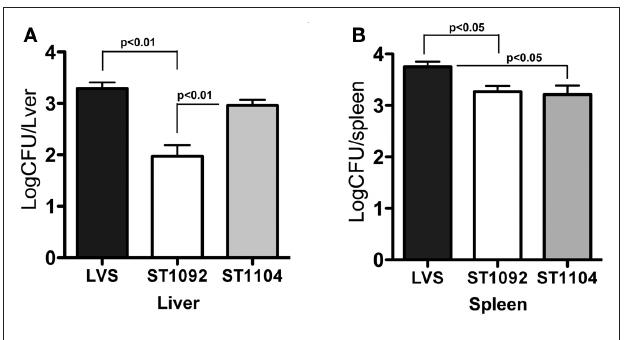
Figure A1 | In vivo growth of the F. tularensis ∆ capB mutants in the livers (A) and spleens (B) of BALB/c mice. BALB/c mice were infected individually with LVS (4,500 CFUs), ST1092 (5,100 CFUs), or ST1104 (4,800 CFUs) by intranasal inoculation. Bacterial levels in the livers and